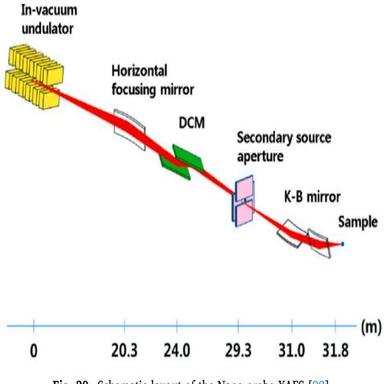
Schematic layout of the Nano-probe XAFS.